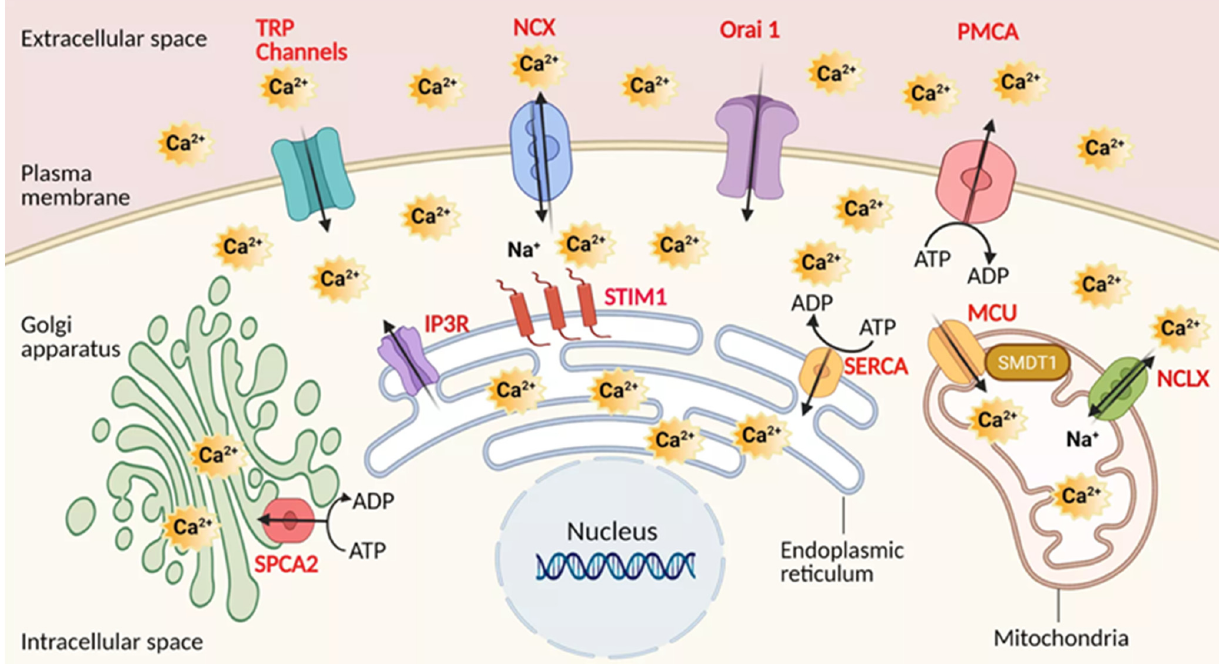
Figure 1. Calcium transporters in Pancreatic ductal adenocarcinoma (PDAC). Channels, pumps, exchangers are depicted